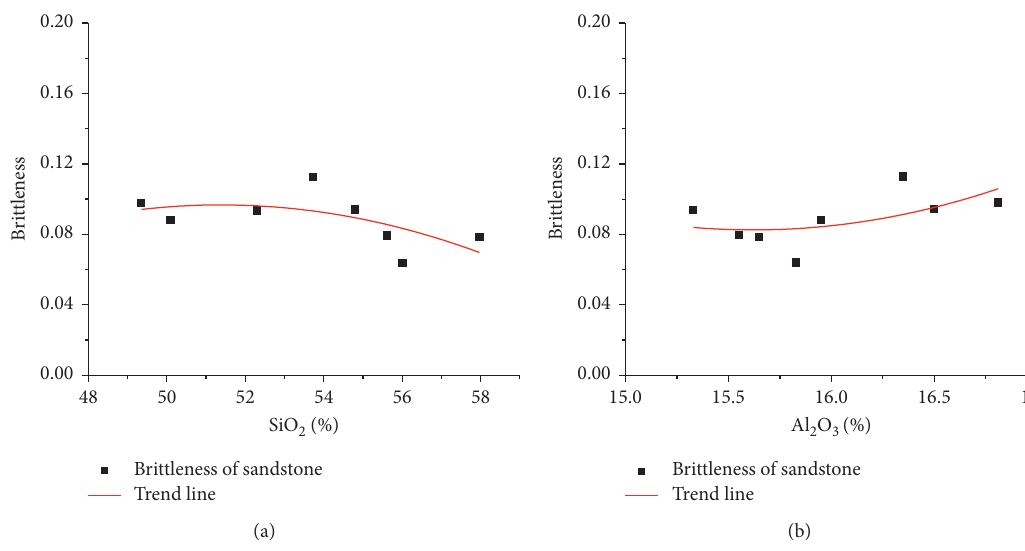
Figure 12: Relationship between mineral composition and brittleness of deep sandstone